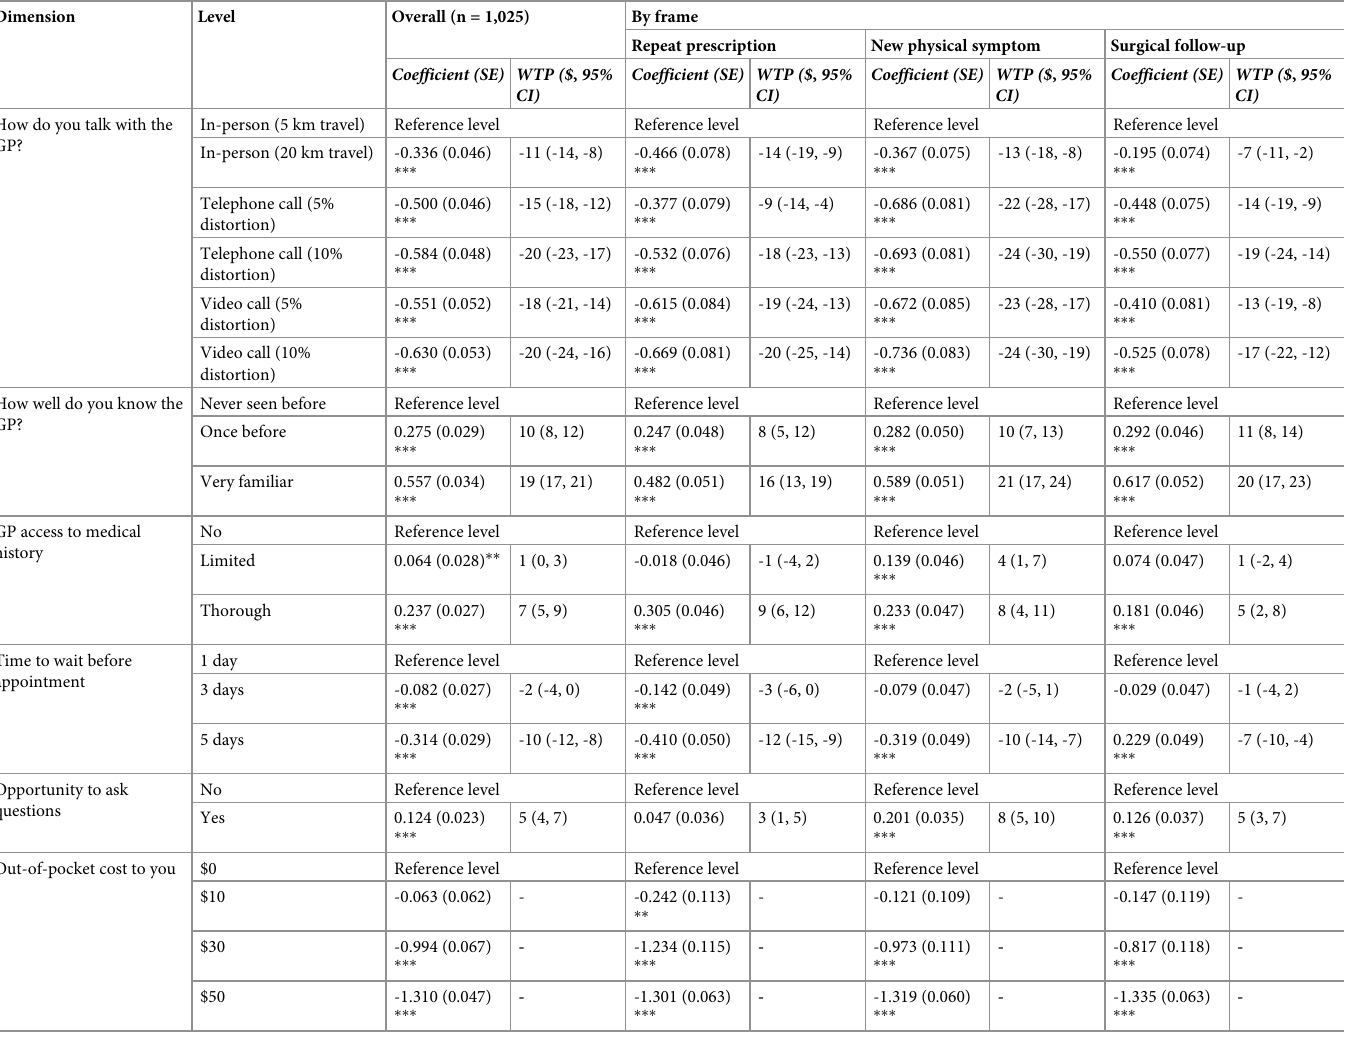
Table 3. Results from conditional logit models, overall and by